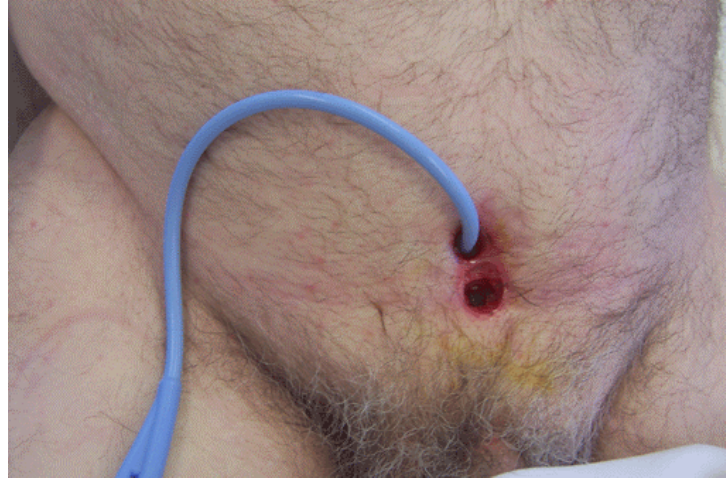
FIGURE 1. Clinical photograph of the patient. The suprapubic catheter was hanging loosely. There was a hole below the suprapubic cystostomy through which small amount of urine was